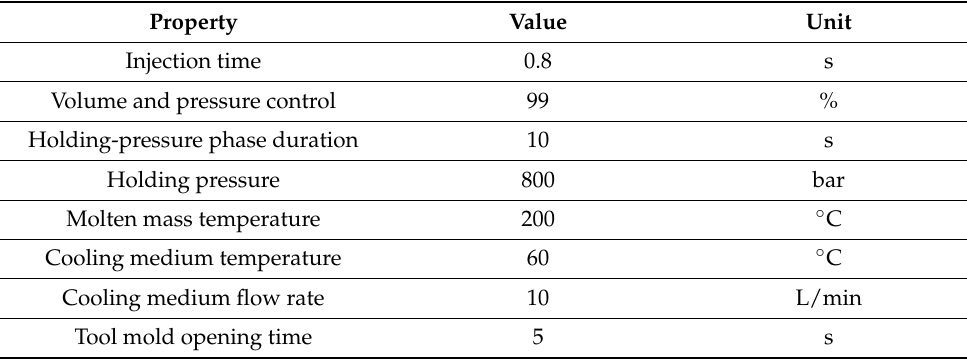
Figure 6. Model sketch of the initial configuration (mesh for tooling is omitted), cooling channels are given in blue; channels including pass partition plates are highlighted in yellow. Table 1. Process parameters for injection molding simulation.